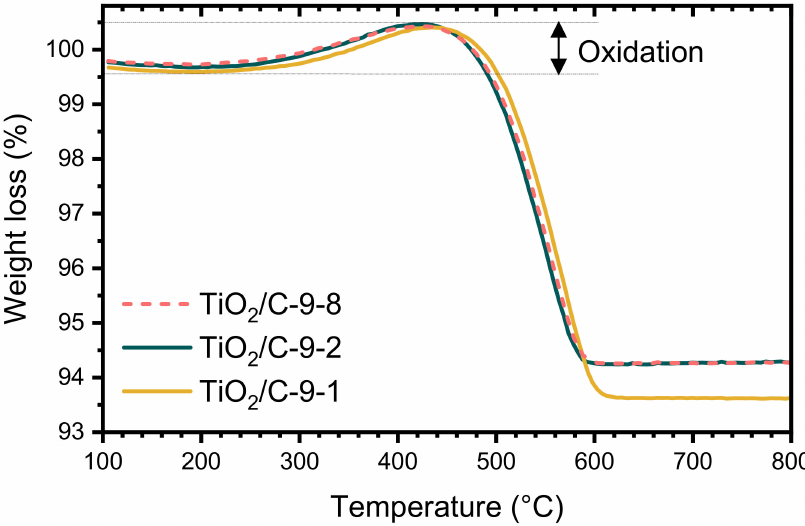
Figure 3. Thermogravimetric analyses (TGA) performed under synthetic dry air flow (50 mL min − 1 ) at 10 ◦ C min − 1 of TiO 2 / C-9- y